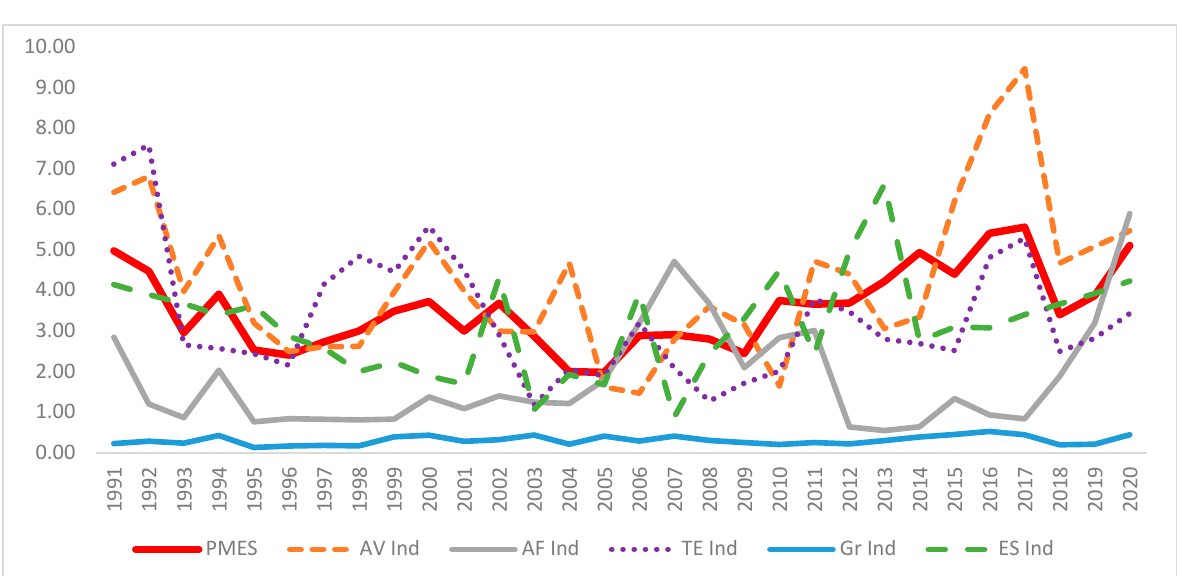
Figure 2. Energy security performance of Pakistan.